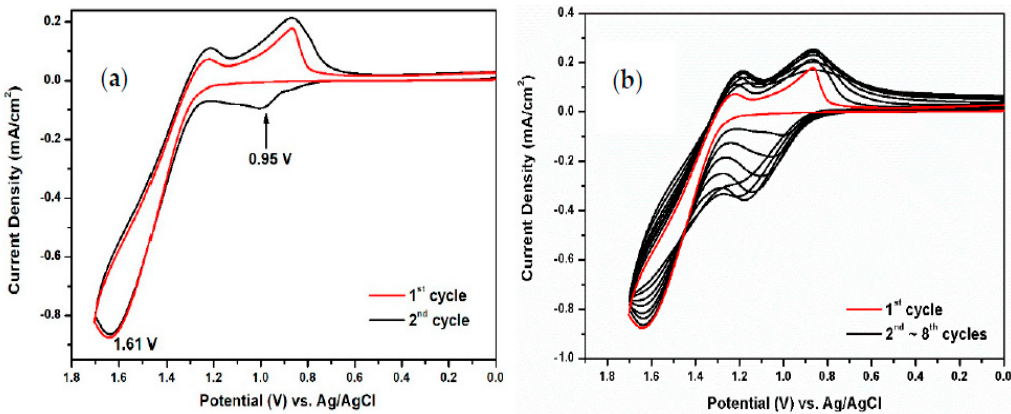
Figure 9. ( a ) The first two cyclic voltammograms and ( b ) eight repeated potential scanning of 2 mM of NPC–TPDI in 0.1 M Bu 4 NClO 4 /CH 2 Cl 2 solution between 0 and 1.70 V at a scan rate of 50 mV · s − 1 .